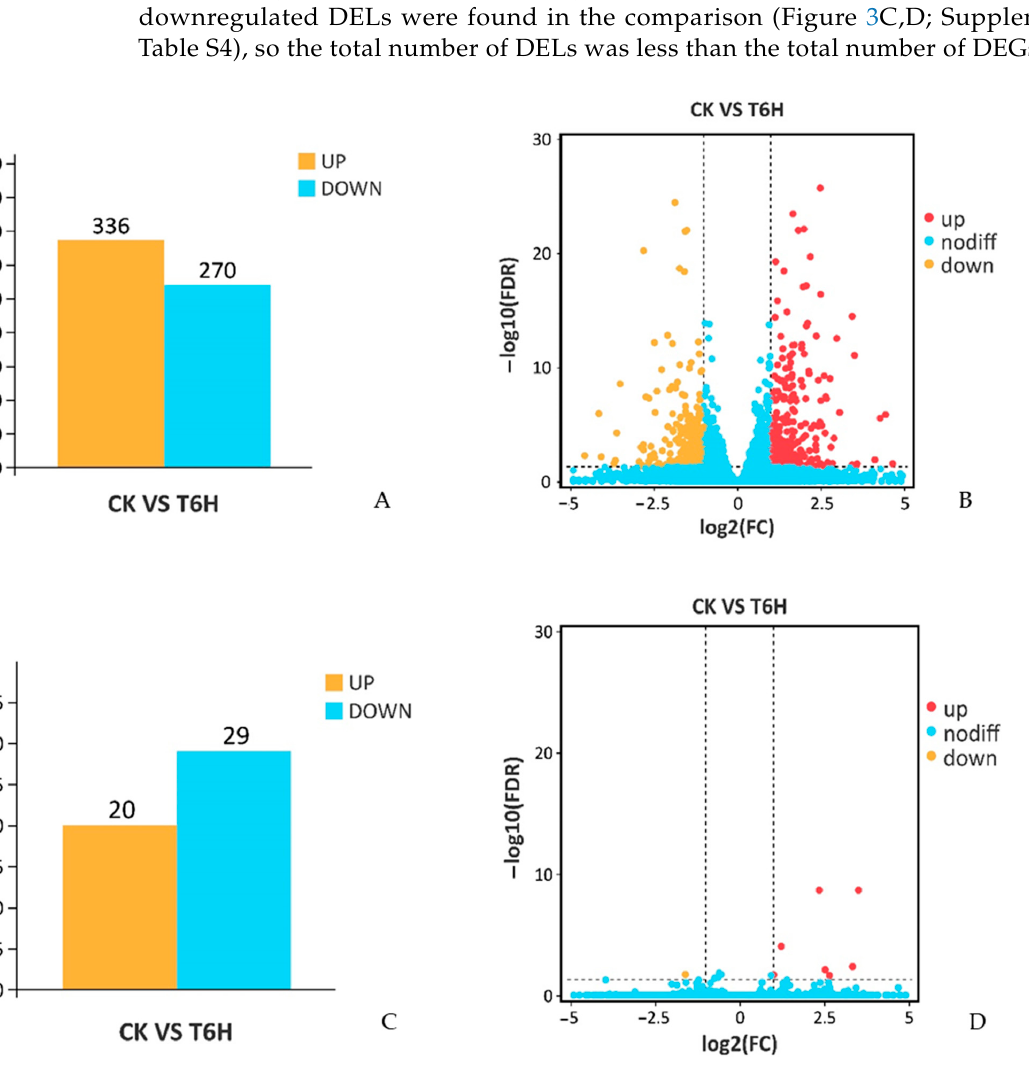
Figure 3. Comparison of differentially expressed genes (DEGs) and lncRNAs (DELs). ( A ) The number of DEGs, ( B ) the distribution of DEGs, ( C ) the number of DELs, ( D ) the distribution of DELs. CK, control samples; T6H, SA-treated samples.